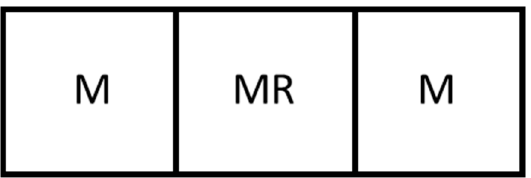
Figure 12. The optimum 3-mod design that maximizes the size of the AOS. In this case, this design